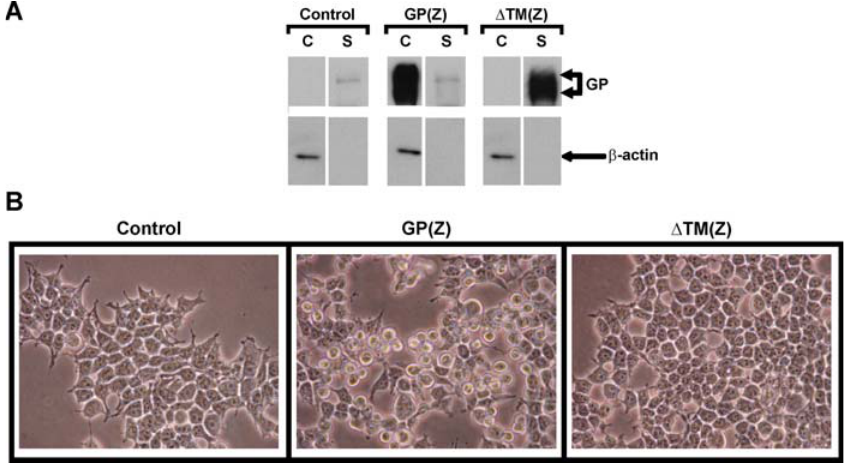
Figure 1. Elimination of GP Cytopathic Effects and Expression of Transmembrane-Deleted Protein (A) Expression of GP( D TM) in HEK293 cells. Ebola GP proteins from supernatants and cell lysates were visualized by SDS-PAGE and Western blot using a polyclonal antibody against Ebola GP. (B) Elimination of cell rounding by GP D TM. HEK293 cells were transfected with a plasmid that encoded vector control, Ebola GP, or Ebola GP D TM. Cell monolayers were visualized under phase contrast using a Nikon 40 3 objective and photographed at 24 h posttransfection. DOI: